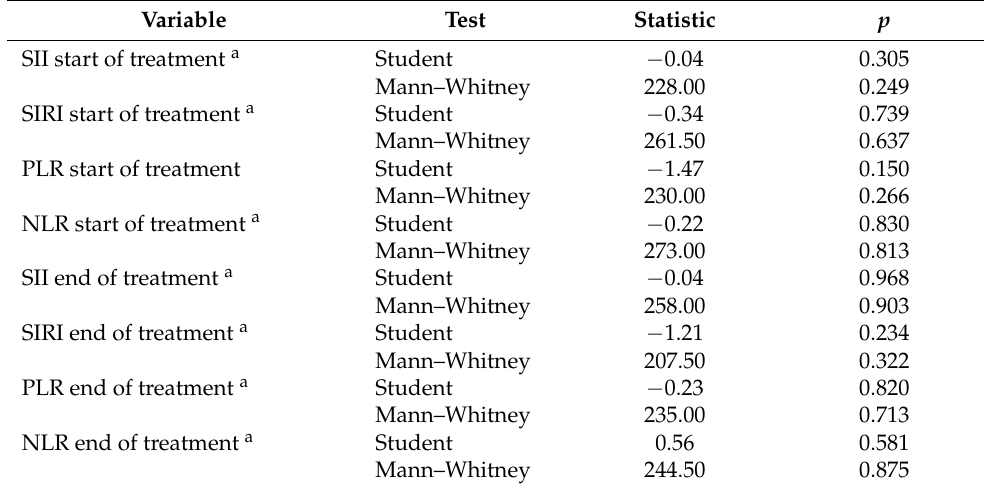
Table 2. Comparison of index levels between groups (responders vs. non-responders).